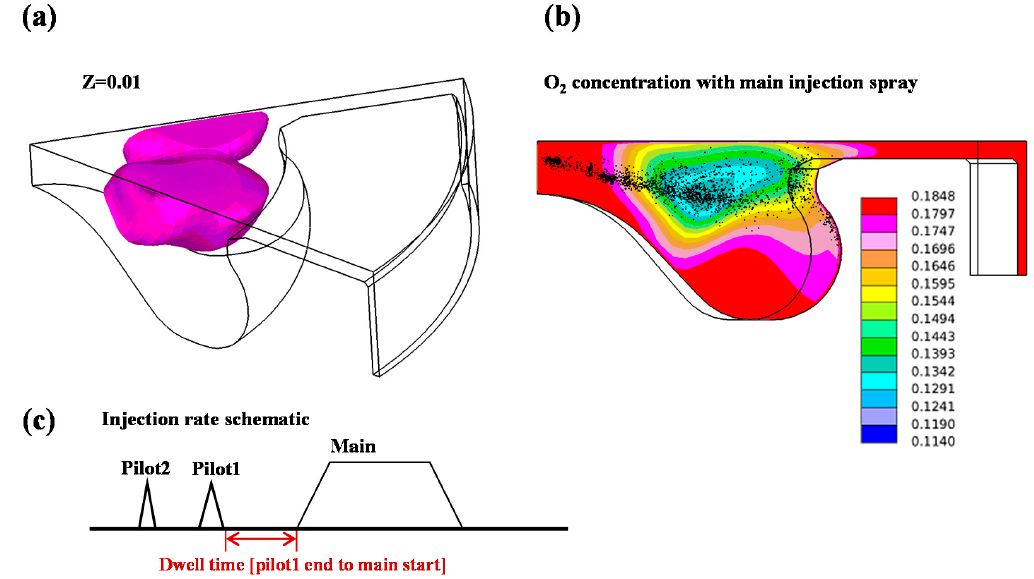
Figure 4. The CFD simulations at 6 aTDC CA showing ( a ) the mixture fraction contours at Z = 0.01; ( b ) the O 2 mole fraction with the main injection spray. The reference condition was 1500 rpm, pilot2 1.1/pilot1 1.35 mg/str, DT 7.24CA, main injection timing at 0.7 bTDC CA; and ( c ) Injection rate schematic. (bTDC means before top dead center).